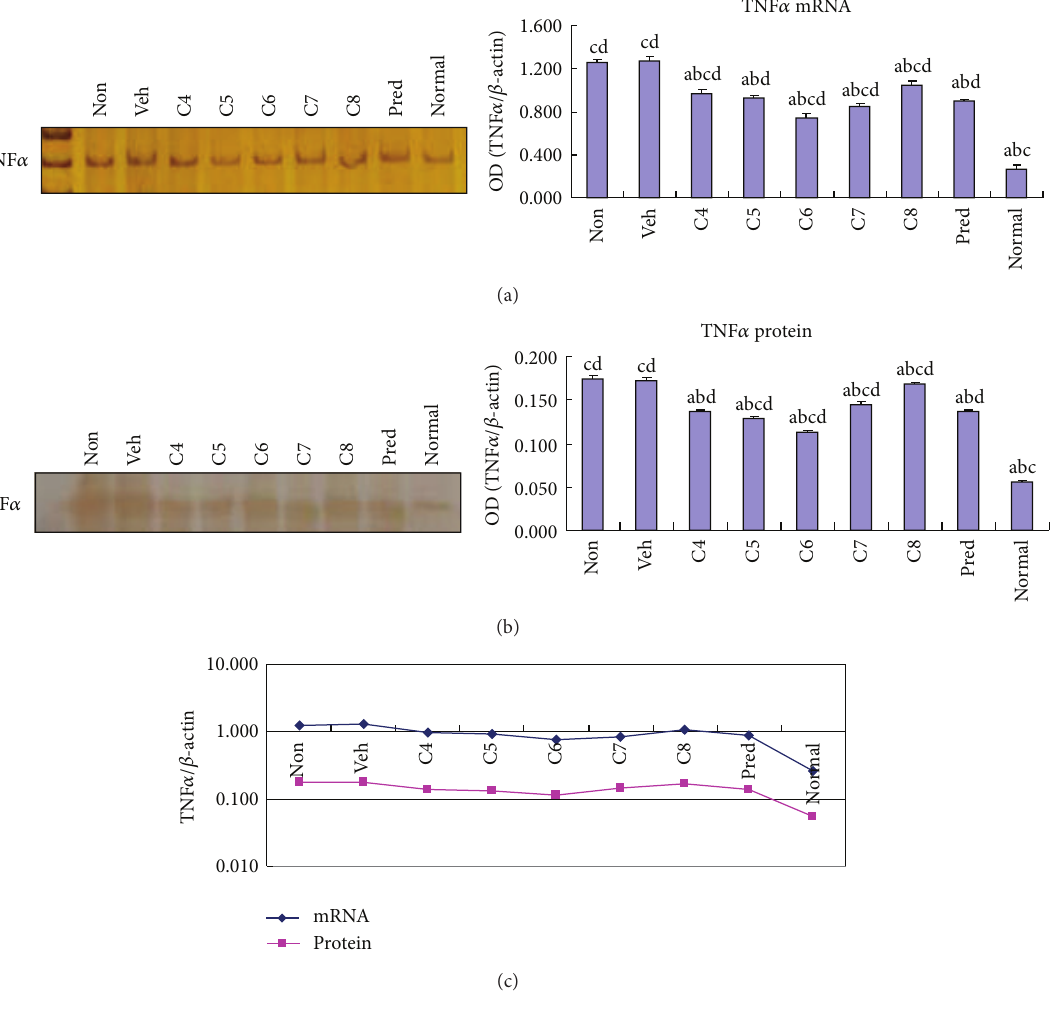
Figure 2: Lactobacillus acidophilus treatment suppressedTNF 𝛼 expression in colitis. ThemRNA(a) and protein (b)levels of TNF 𝛼 expression were examined by RT-PCR and Western blotting, respectively, in the colonic tissues of normal control mice group (normal) and DSS-induced mice groups, including L. acidophilus -treated C4–C8 groups, prednisone acetate treated positive control (Pred), and nontreated (Non) and vehicle (Veh) treated control groups. Representative electrophoresis images are shown on the left, and bar graphs presenting mean ± SD ( 𝑛 = 8 ) values are shown on the right. A plotted trendline chart shows TNF 𝛼 expression in each group at both mRNA and protein levels (c). a 𝑃 < 0.05 versus Non, b 𝑃 < 0.05 versus Veh, c 𝑃 < 0.05 versus Pred, and d 𝑃 < 0.05 versus